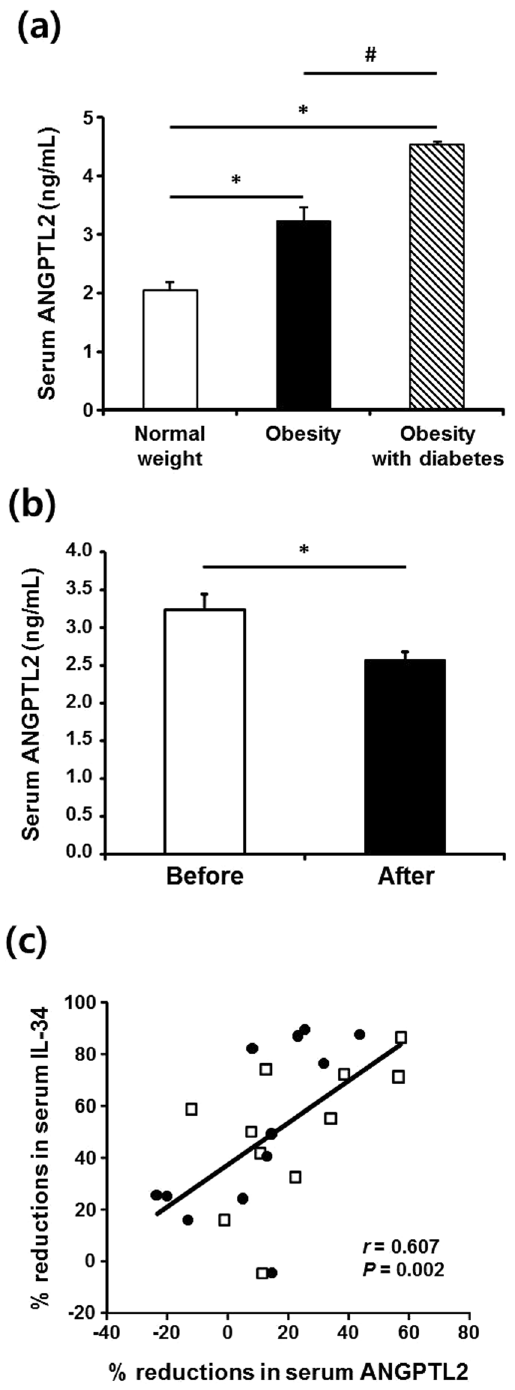
Figure 3. Serum ANGPTL2 concentrations and ANGPTL2 mRNA expression in human. ( a ) Serum ANGPTL2 concentrations in patients with obesity (n = 31), obesity and type 2 diabetes (n = 14), and normal-weight control patients (n = 32). Data are log-transformed for statistical analysis and shown as the mean ± SE on the original (back-transformed) scale. * p < 0.01 vs. control, # p < 0.01 vs. obesity group according to ANOVA and the Tukey’s test. ( b ) Significant reduction in serum ANGPTL2 concentration following RYGB surgery in obese patients. Serum ANGPTL2 concentration and metabolic parameters were measured before and 5–9 months (average 7.3 months) after surgery in a subgroup of obese patients ( n = 23). * p < 0.01 vs. before surgery according to paired t -test. ( c ) Close association between percentage reduction in serum ANGPTL2 concentrations and percentage reduction in serum IL-34 following the surgery. Percent reduction in serum ANGPTL2 was calculated as [(serum ANGPTL2 before surgery – serum ANGPTL2 after surgery) ÷ serum ANGPTL2 before surgery] × 100. The correlation coefficient ( r ) between changes in measurements was calculated using Spearman’s